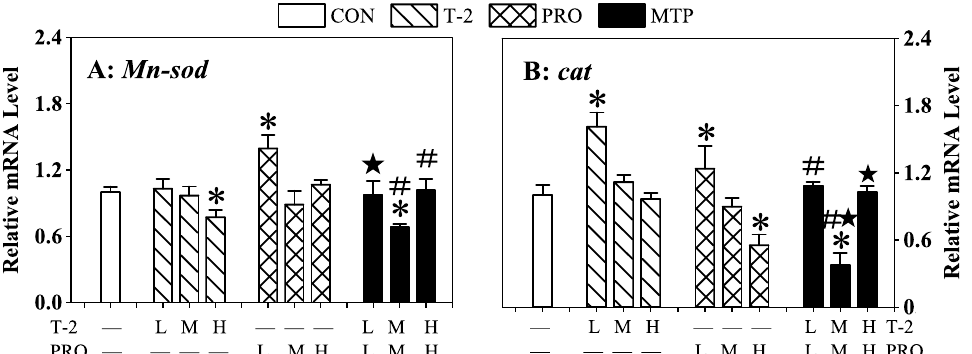
Fig. 4 Influences on expressions of genes associated with the anti-oxidative systems in fish administrated with T-2 PRO and their combinations. A Mn-sod , B cat . Each bar represents the mean standard deviation ( n three replicates consisting of a group of 50 fish). * p < 0.05 substantial ± = alteration by comparison with the control; # p < 0.05 significant difference relative to the corresponding T-2 exposure; ★ p < 0.05 significant difference relative to the corresponding PRO exposure. CON control, T-2 T-2 toxin, PRO propiconazole, MTP the mixture of T-2 and PRO. L low concentration, M middle concentration, H high